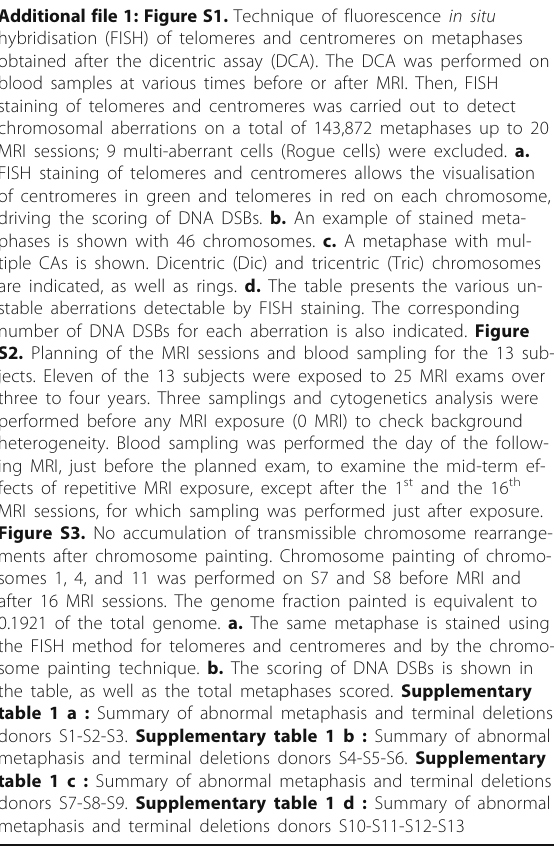
table 1 c : Summary of abnormal metaphasis and terminal deletions donors S7-S8-S9. Supplementary table 1 d : Summary of abnormal metaphasis and terminal deletions donors